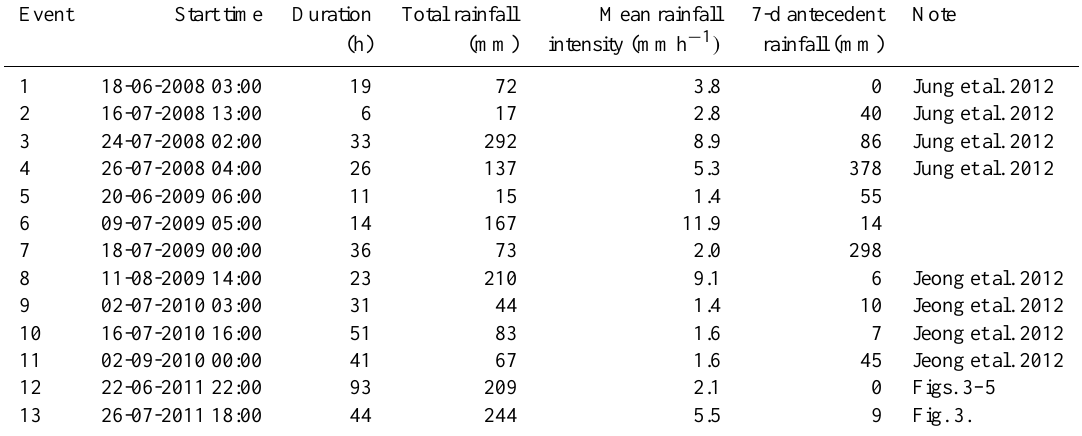
Table 1. Characteristics of 13 monsoon rainfall events. Original data of DOC and POC concentrations from eight events that were published elsewhere (references provided as notes) are here used to calculate discharge-weighted event mean concentrations and fluxes in Fig. 2. The events 12 and 13 were examined in detail to evaluate potentials of DOC and POC for DBP formation and biodegradation (Figs.